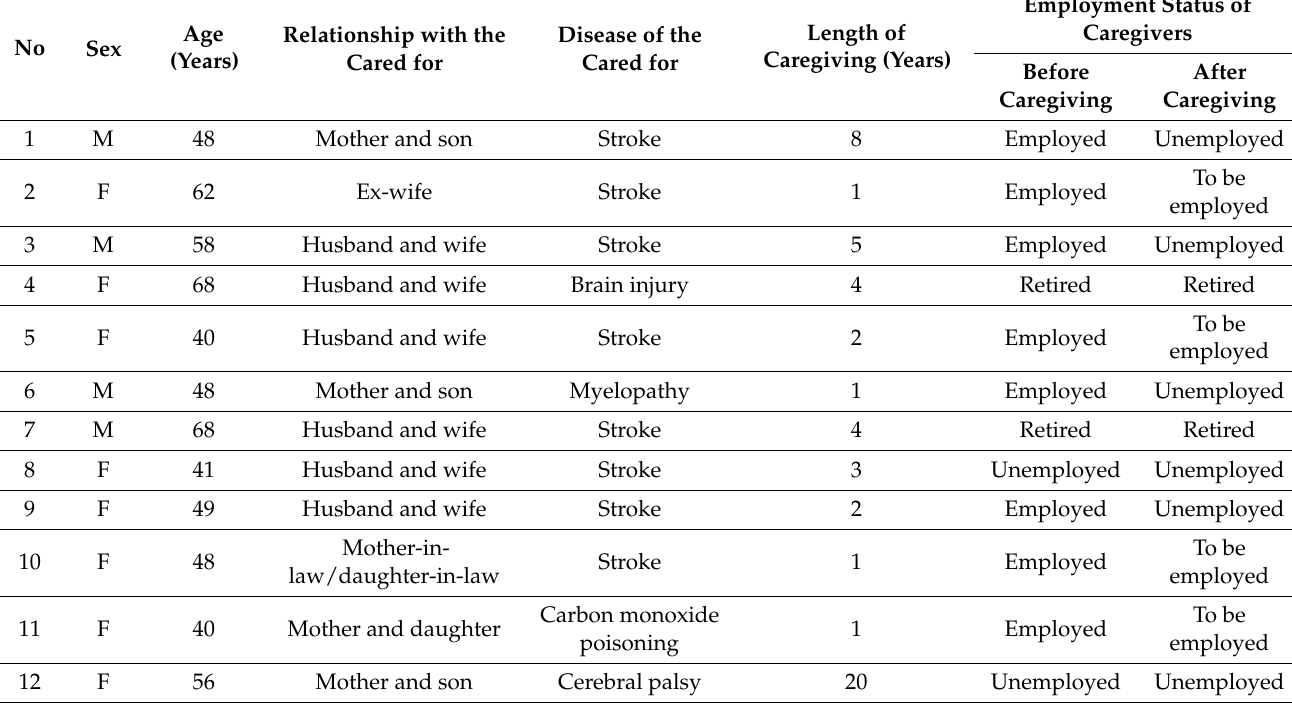
Table 3. Baseline data of